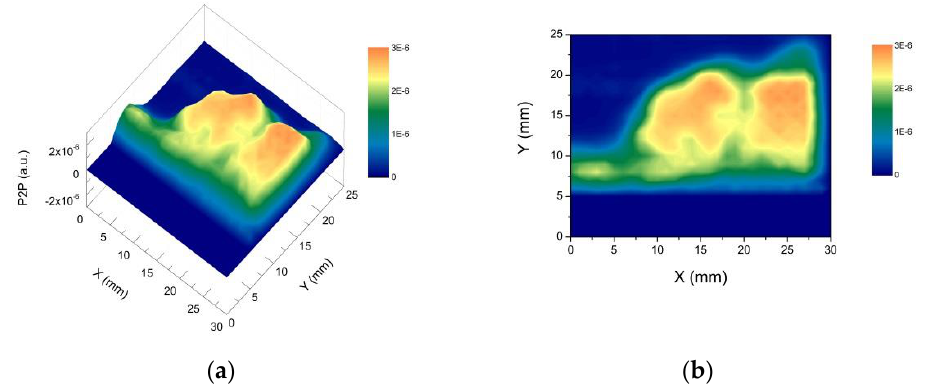
Figure 10. ( a ) THz imaging of the original fragment: on the vertical axis is reported the difference between the maximum and the minimum of each waveform; on the horizontal and vertical axes, the label of the measuring points; ( b ) THz horizontal projection; ( c ) color scale in arbitrary units.